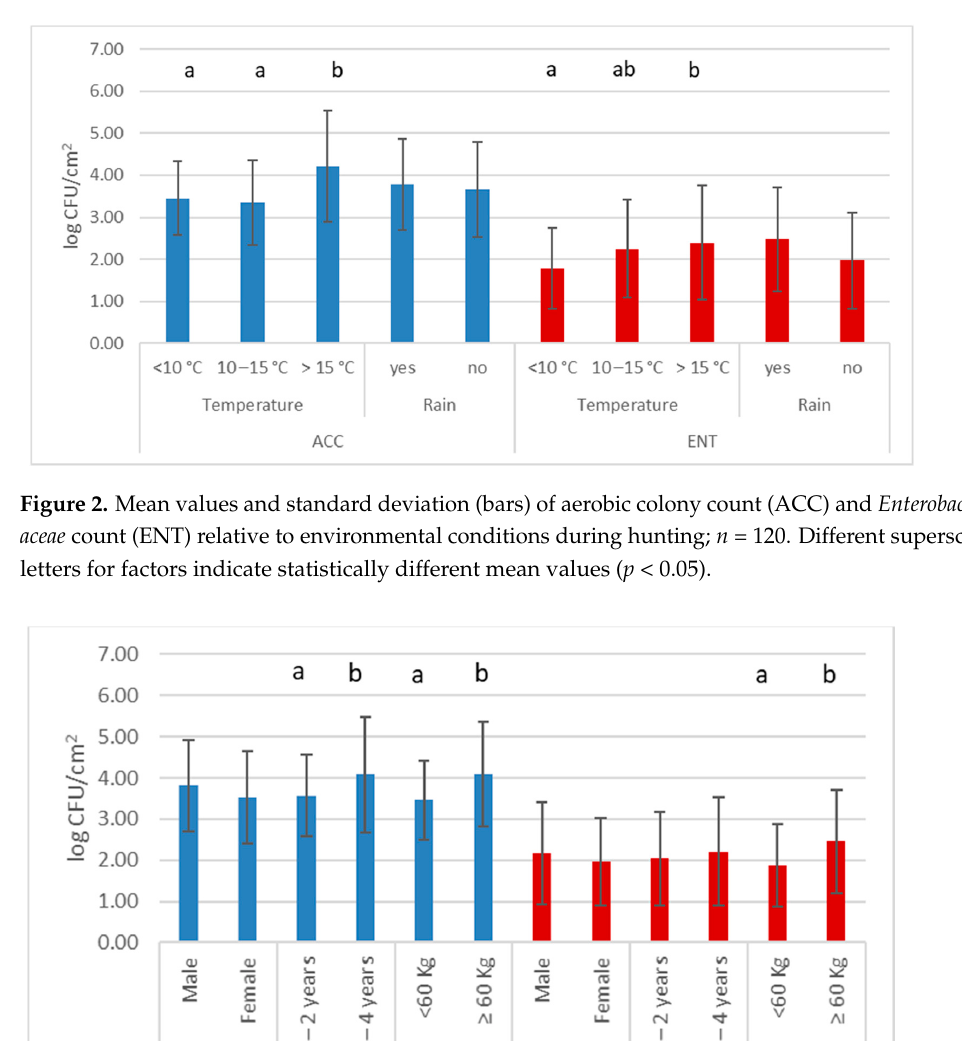
Table 3. Mean values of aerobic colony count (ACC) and Enterobacteriaceae count (ENT) relative to hunting methods and characteristics (in log CFU/cm 2 ; n = 120). Hunting methods